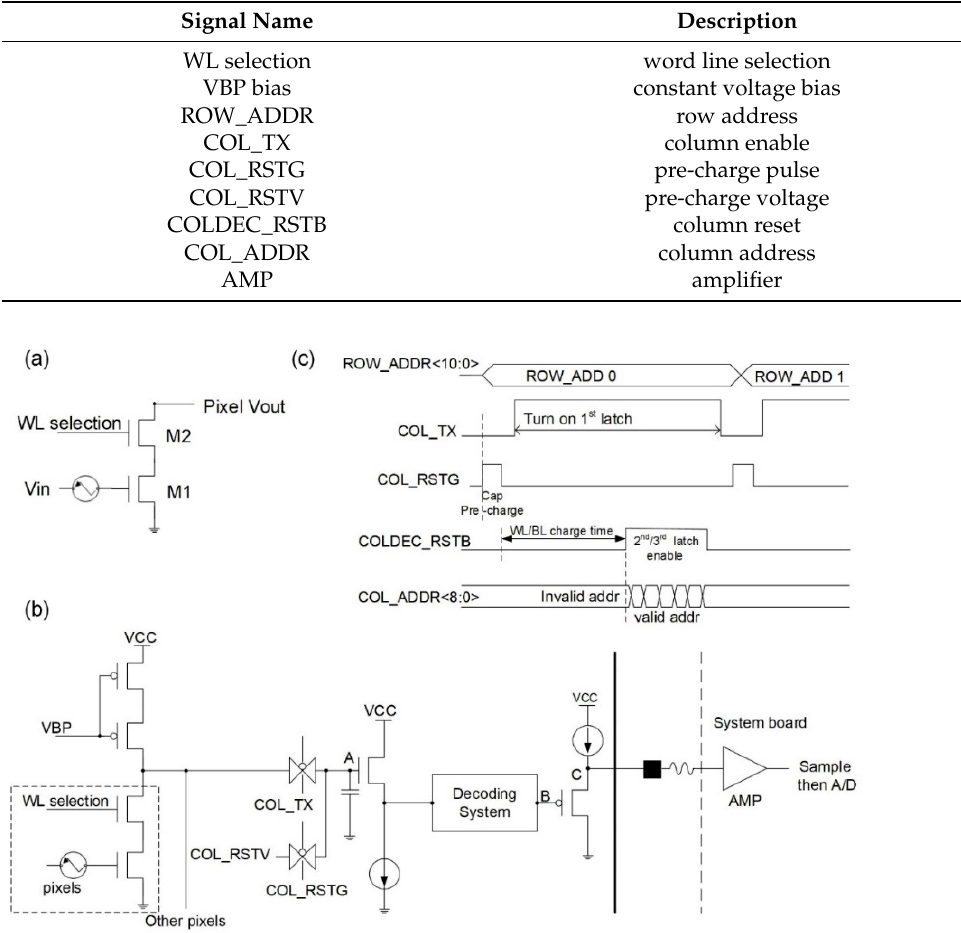
Figure 3. Pixel readout circuit structure and circuit timing diagram. ( a ) Pixel circuit structure; the pixel circuit consists of only two transistors, forming a common-source and common-gate structure. ( b ) Pixel readout circuit structure; when the pH value changes, the output current of the ISFET in the pixel circuit also changes, and the pixel readout circuit converts the current signal into the voltage signal and output it to the external analog-to-digital converter. ( c ) Pixel readout circuit timing diagram; the pixel signals are read according to the timing diagram of the readout circuit; the activation and effective transmission of each pixel unit are controlled by timing.